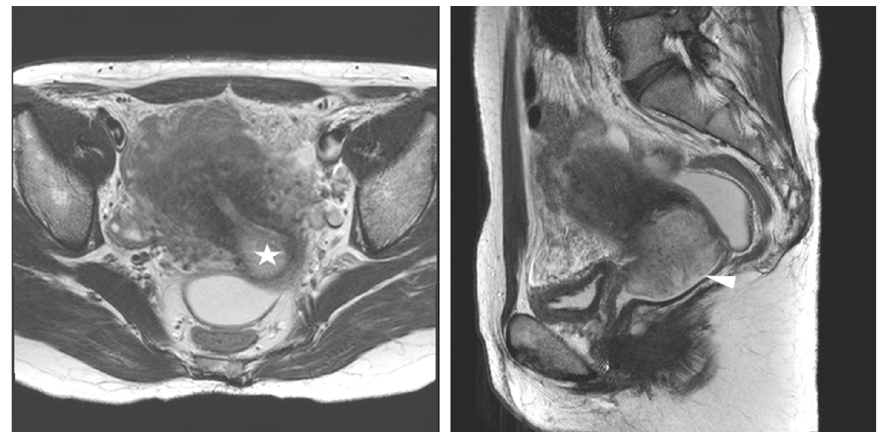
Figure 7: Stage IB2 cervical adenocarcinoma in a 48-year-old woman with radical hysterectomy (A) T2-weighted axial MR images show a 5 cm well defined exophytic mass (star) mainly involving right posterior exocervix with no disruption of peripheral rim. The maximum diameter of the lesion is measured 5cm (arrowhead) on the T2-weighted sagittal image. At histopathological finding, bilateral parametrial lesion was found. MRI stage T1b ( > 4 cm) was underdiagnosed as final pathologic stage